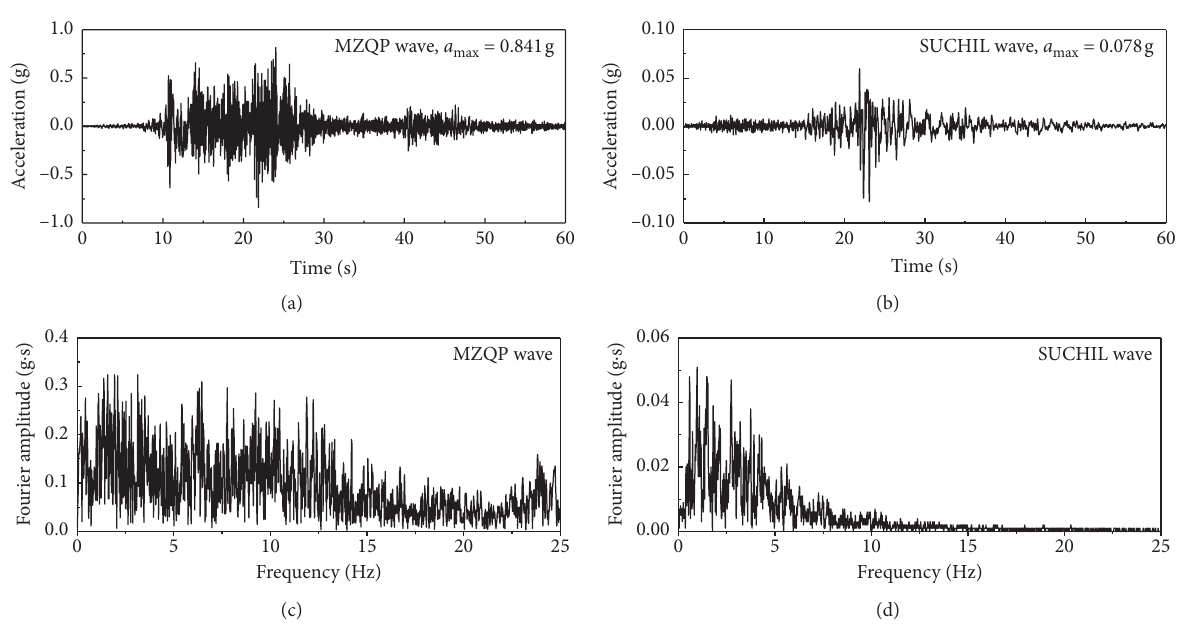
Figure 7: Acceleration time history and Fourier spectrum of input bedrock ground motion.